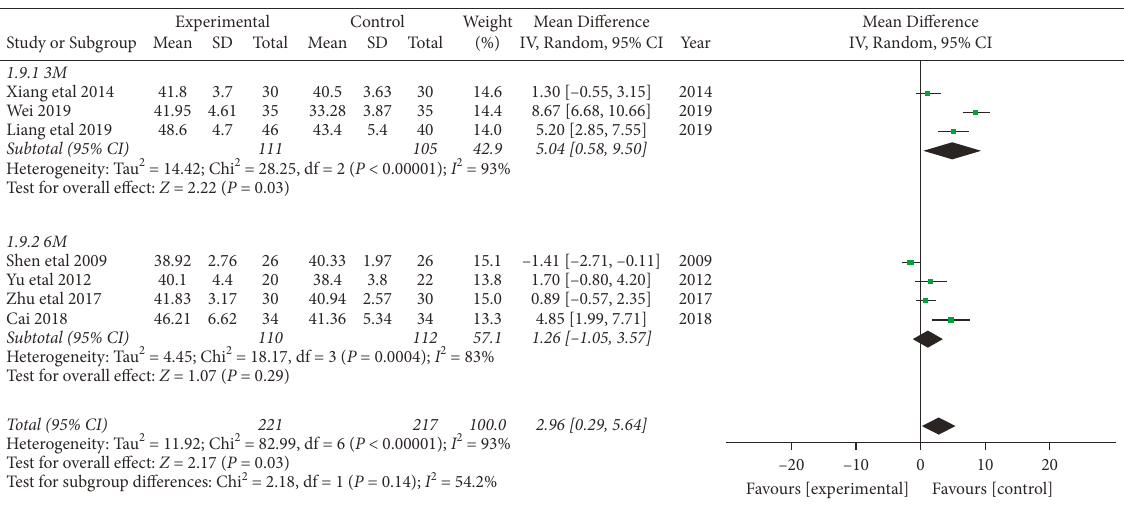
Figure 7: Comparison of GTW combined with RASI versus control group ALB-3 months versus 6